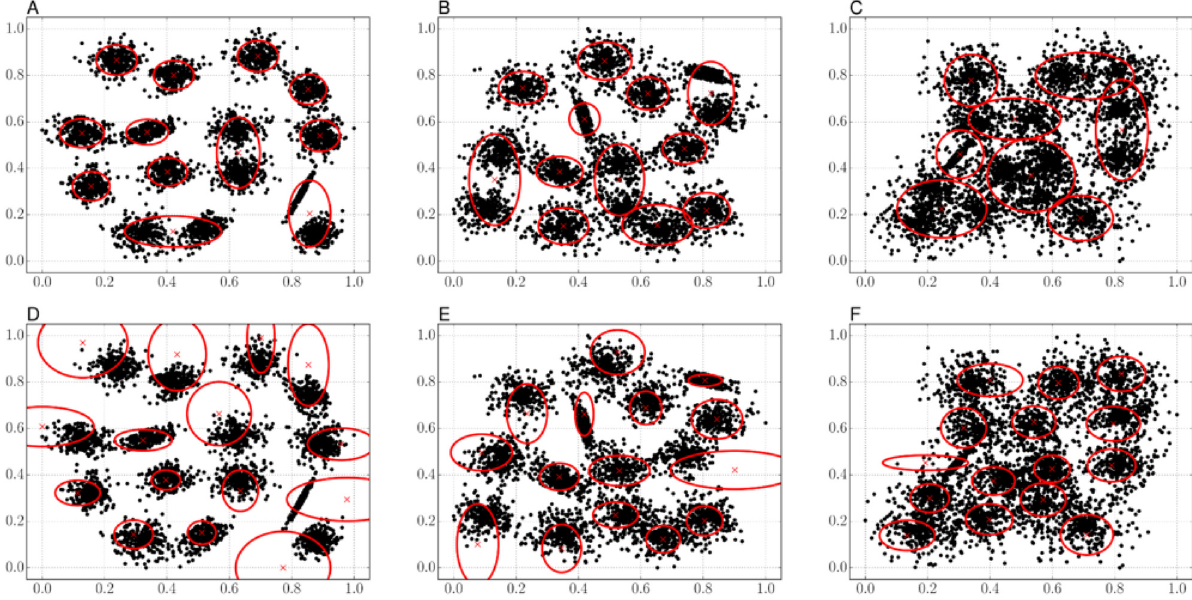
Fig 2. Illustrative examples of the estimated Gaussians on the S-sets. (A–C) The estimated Gaussians by the GMM for S1, S2, and S3 respectively. (D–F) The estimated Gaussians by our proposal for S1, S2, and S3 respectively. The black circles show the clustering sample positions, and the red cross and the ellipse respectively show the mean position and the confidence corresponding each Gaussian.